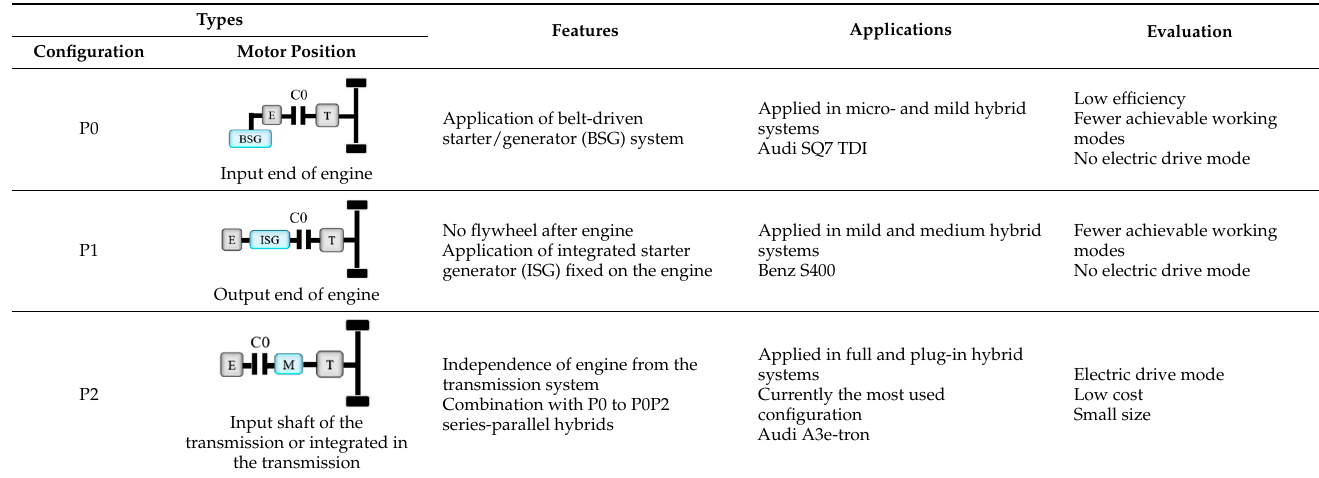
Table 2. Features and applications of parallel P0–P4 configurations [11,12].